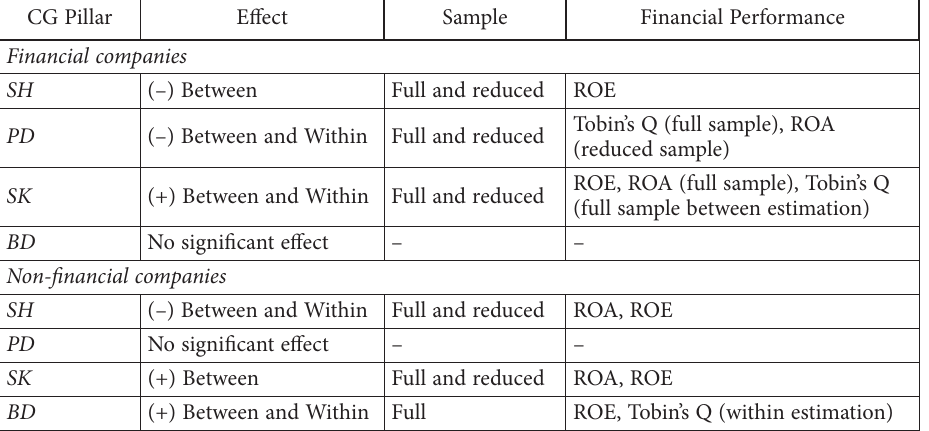
Table 8. Summary